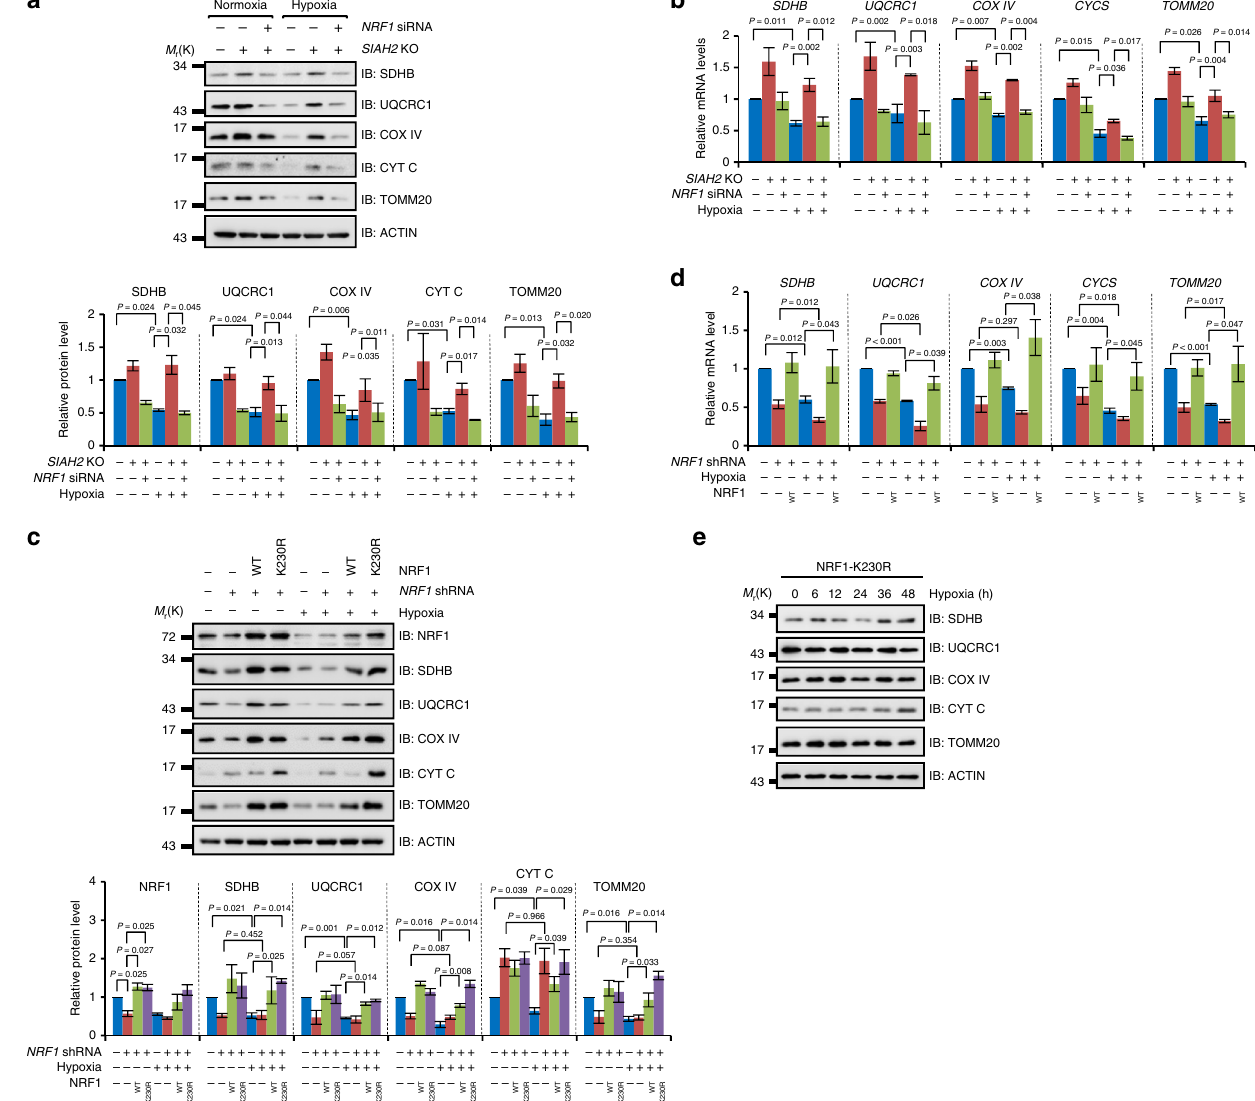
Fig. 5 SIAH2 regulates nuclear-encoded mitochondrial gene expression through NRF1. a Wild-type or SIAH2 − / − MDA-MB-231 cells were transiently transfected with scramble or NRF1 -targeted siRNA then cultured under normoxia or hypoxia for 36 h. Cells were harvested and analyzed by western blotting. Bottom: densitometric quanti fi cation of the indicated proteins. b Statistical analysis of qRT-PCR data from cells treated as in ( a ). qRT-PCR results were normalized to the housekeeping gene B2M . c Stable NRF1 -knockdown MDA-MB-231 cells reconstituted with wild-type NRF1 or the NRF1-K230R mutant, together with mock and NRF1 -knockdown MDA-MB-231 cells, were cultured under normoxia or hypoxia for 36 h and analyzed by immunoblotting. Bottom: densitometric quanti fi cation of the indicated proteins. d Cells treated as in ( c ) were analyzed by qRT-PCR and the data were statistically compared. qRT-PCR results were normalized to the housekeeping gene B2M . e MDA-MB-231 cells stably expressing K230R-NRF1 were cultured under hypoxia and then analyzed by immunoblotting using the indicated antibodies at the indicated time points. Detailed statistical data are shown in Supplementary Fig. 2d. For all panels, error bars indicate s.d., n = 3 biological replicates, average of n = 3 technical replicates for each biological replicate was used in ( b ) and ( d ). The two-tailed paired ratio t -test was used to compare data in (a-d) and one-way ANOVA was used to compare data in ( e